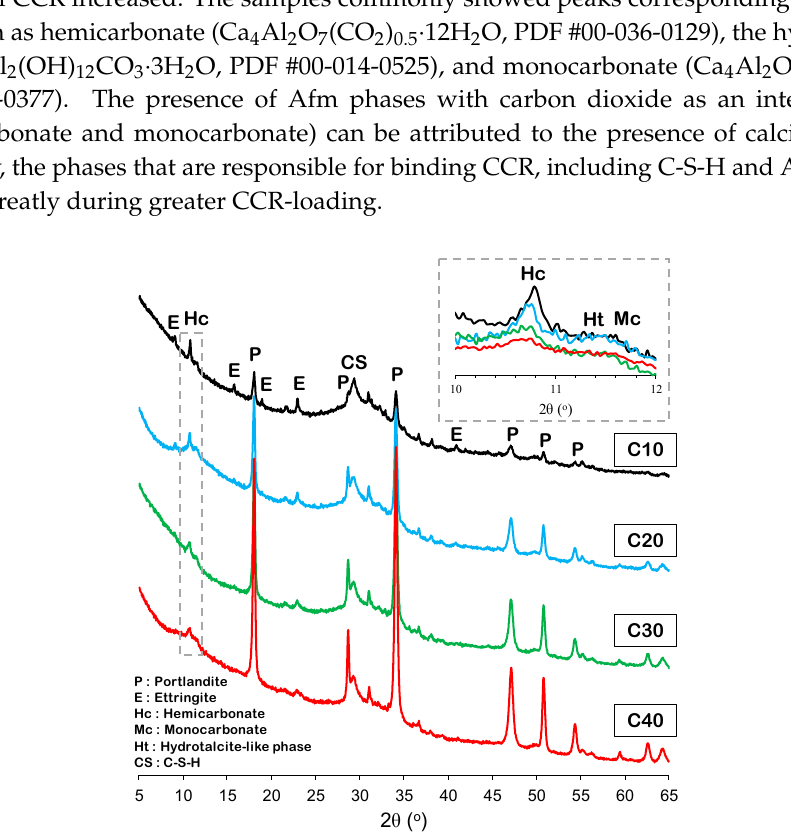
Figure 2. X-ray di ff ractograms of the mixtures of slag and Figure 2. X-ray diffractograms of the mixtures of slag and CCR.